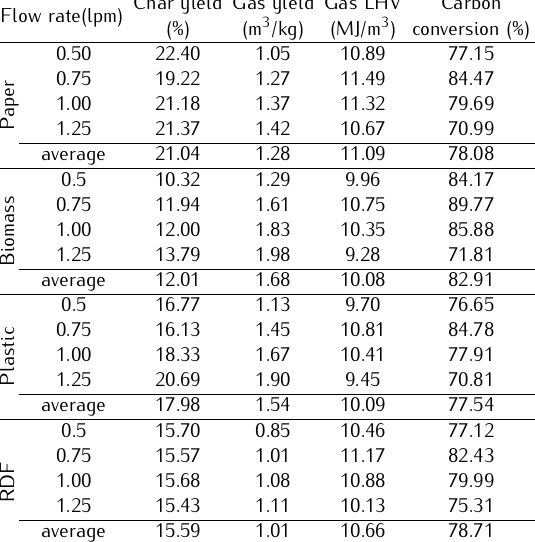
Table 3. Yields of Char and Gas Products